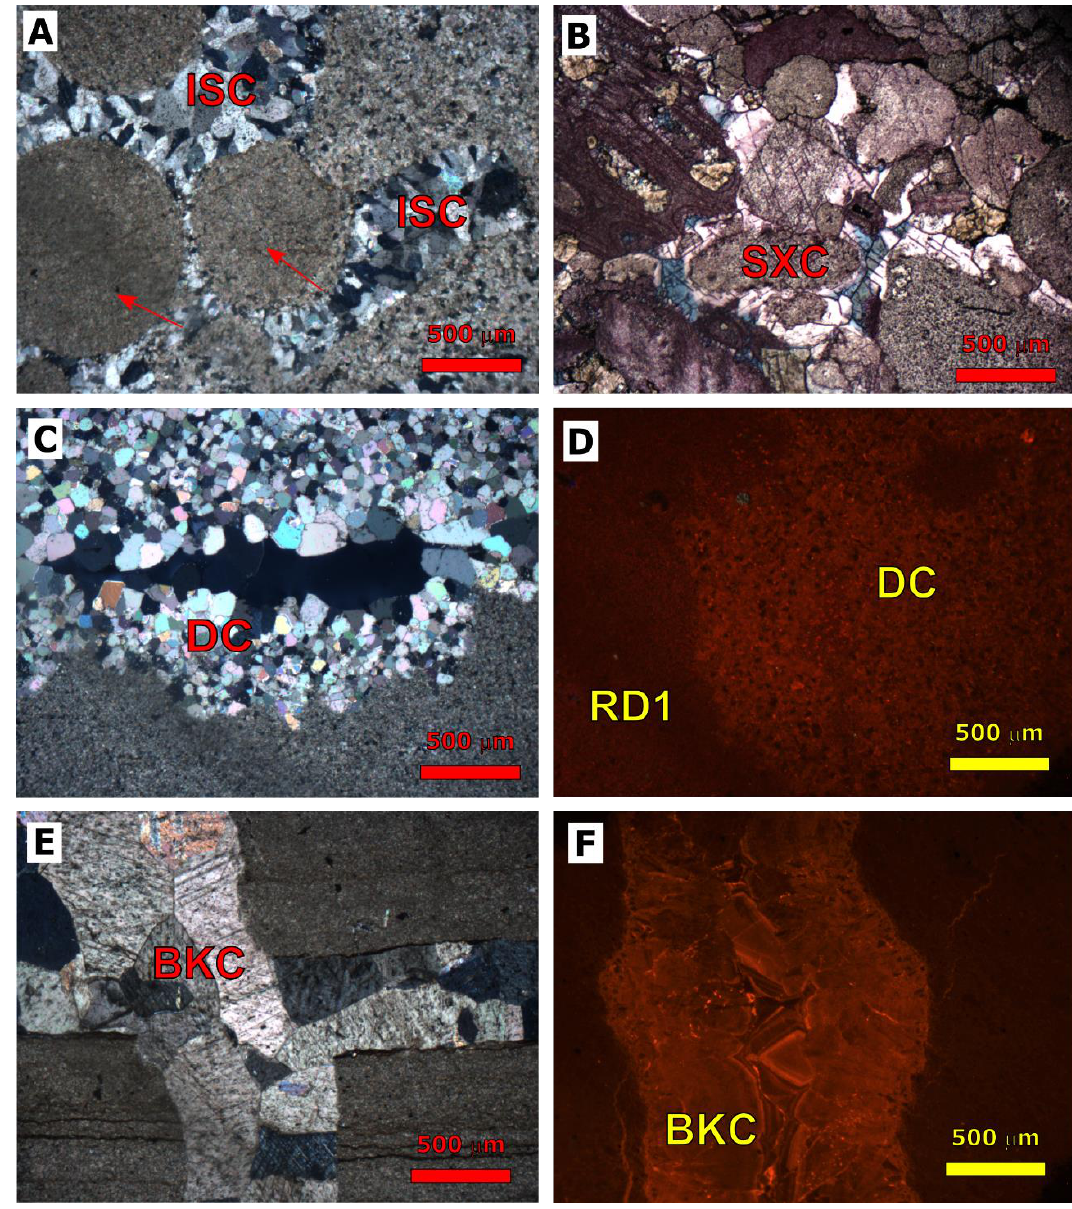
Figure 6. Calcite cementation in Silurian formations. ( A ) Photomicrograph (XPL) of isopachous calcite cement (ISC) filling interparticle pores in coated grains (red arrows). Sample 8-10; well: DGR8-CR122; depth: 332.26 m; ( B ) photomicrograph (PPL—after staining) of ferroan syntaxial overgrowth calcite cement (SXC) on crinoidal and echinoid skeletal fragments in a bioclastic grainstone. Sample 1-33; well: DGR1-CR154; depth: 440.92 m; ( C ) photomicrograph (XPL) of drusy calcite cement (DC) showing increasing crystal sizes towards the center of a vug in a fenestral dolostone. Sample 1-17; well: DGR1-CR49; depth: 142.28 m; ( D ) CL photomicrograph of pervasive replacive fine crystalline dolomite matrix (RD1) and vug-filling drusy calcite cement (DC) both showing dully-red luminescence. Sample 1-17; well: DGR1-CR49; depth: 142.28 m; ( E ) photomicrograph (XPL) of a single generation of blocky calcite cement (BKC) filling fractures in a fine crystalline, laminated dolostone. Sample 8-5; well: DGR8-CR64; depth: 182.06 m. ( F ) CL photomicrograph of fracture-filling, late blocky calcite cement (BKC) showing red to bright zoned luminescence. Sample 1-26; well: DGR1-CR119; depth: 333.48